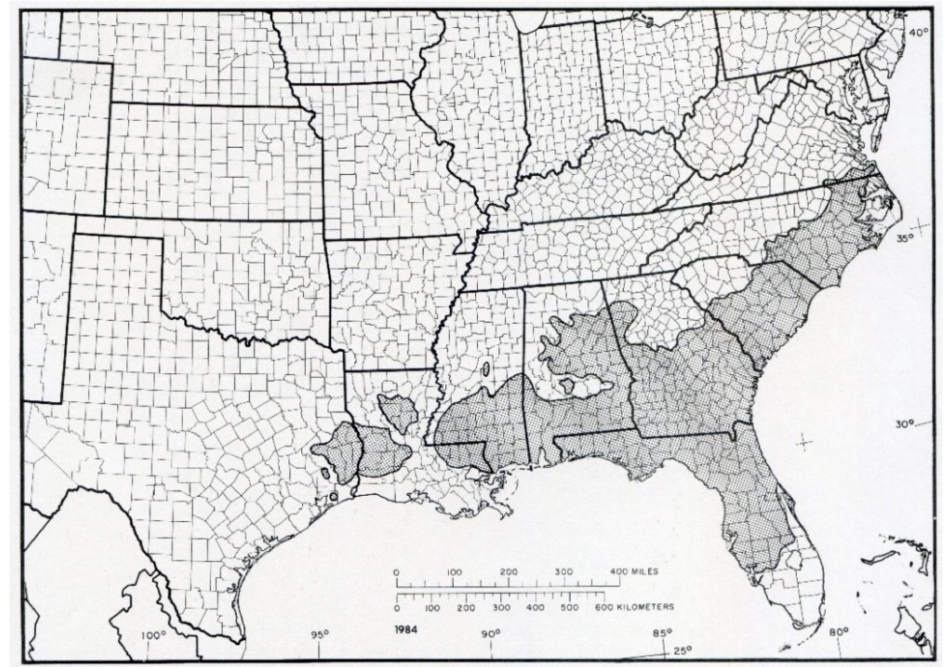
Figure 1. Native range of longleaf pine ( Pinus palustris Mill.)